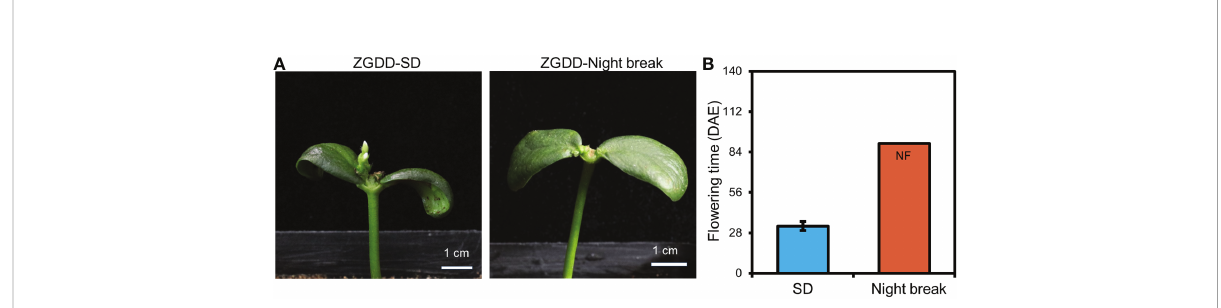
FIGURE 3 The fl owering time of cotyledon-only and intact plants under night break treatments. (A) The phenotype of Zigongdongdou (ZGDD) cotyledon- only plants (COPs) treated with short-day (SD, 12 h light/12 h dark) and night break. (B) The fl owering time of ZGDD COPs treated with SD and night break. DAE indicates d after emergence. NF means no fl owering during the experiment. Fifteen plants were calculated in (B) . Error bars indicate the standard